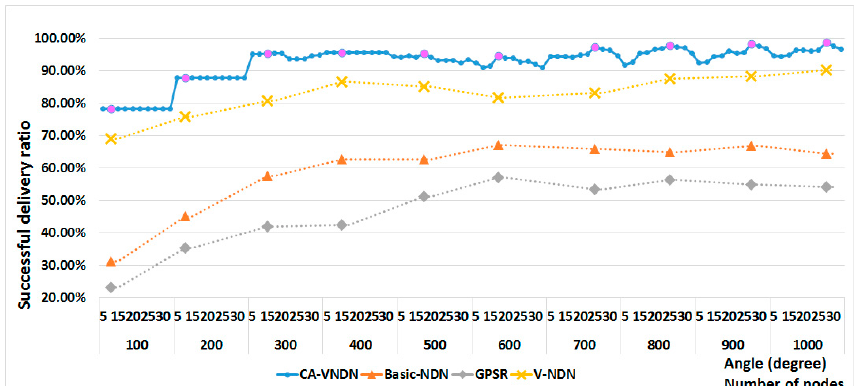
Figure 14. Successful content delivery ratio as a function of the number of nodes and suppression angle.